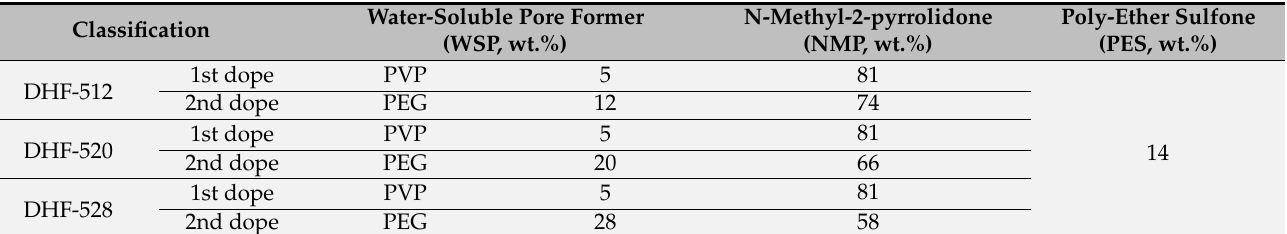
Table 1. Dope solution composition.